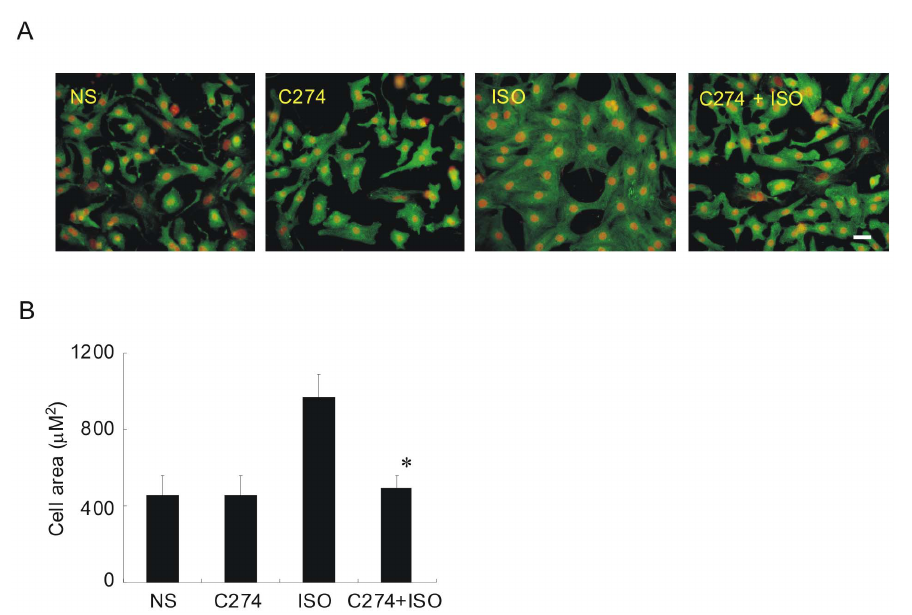
Figure 3. Isoproterenol-induced morphological alterations are prevented by CpG-ODN pre-incubation. (A) immunolocalization of a - actinin in NRVMs. Cells were incubated with an anti- a -actinin followed by reaction with Alexa-488 conjugated second antibody ( green ). PI was used as counterstain for nuclei ( red ). Cells were pre-treated with C274 (5 m g/ml x 12 h) followed by isoproterenol (10 m M x 48 h). Note the highly-organized sarcomeres in isoproterenol-treated cells. Scale bar=20 m m. (B) quantitative analysis of cross-sectional area for each group as shown in (A) ( n =3, * p , 0.05 vs isoproterenol group). For each experiment at least 50 cells were estimated randomly using ImageJ.